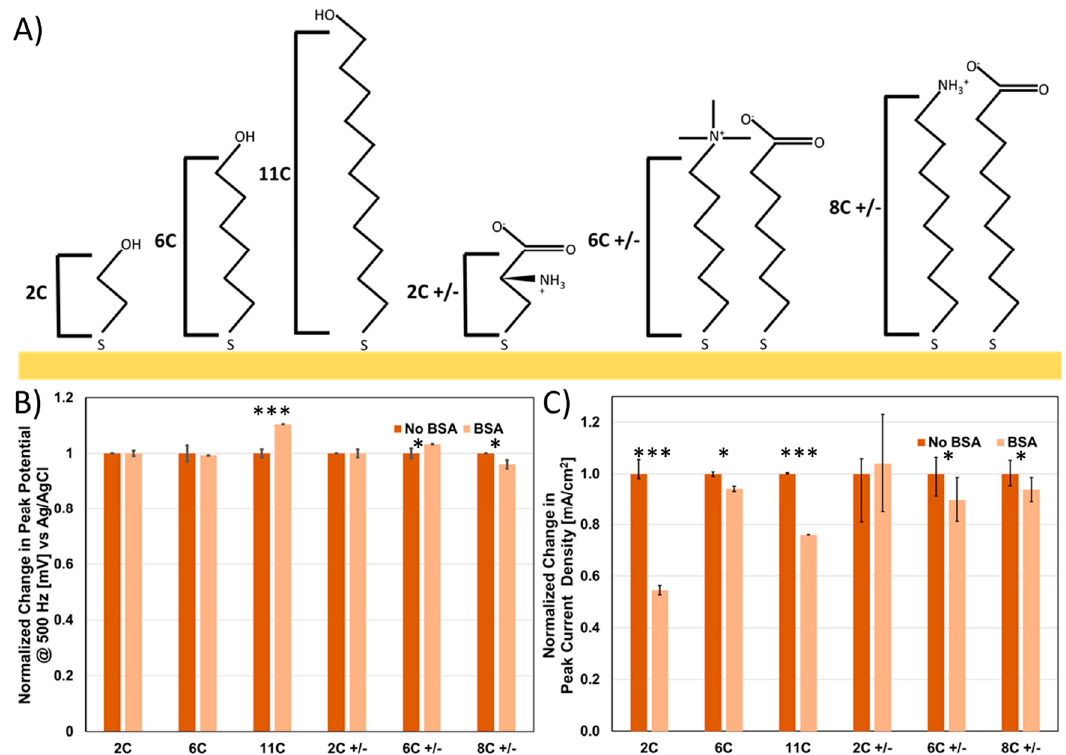
Figure 5. For SAMs of different composition ( A ), a normalized comparison of peak potential ( B ) and peak current ( C ) pre and post addition of the fouling agent bovine serum albumin (BSA) to test resistance to non-specific binding. p values < 0.05 (*), 0.01 (**) and 0.001 (***) determined using a two-tail t-test (n = 4).